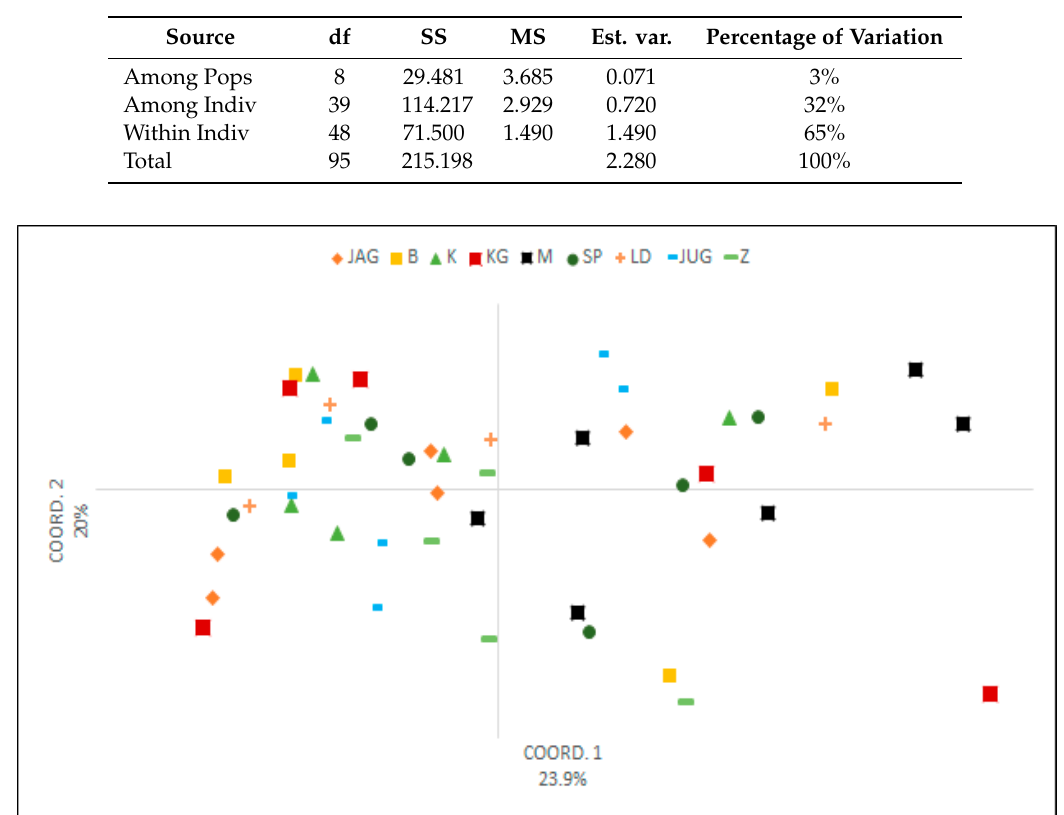
Table 2. Analysis of molecular variances (AMOVA) based on nuclear single sequence repeats (nSSRs) in nine seed orchards.